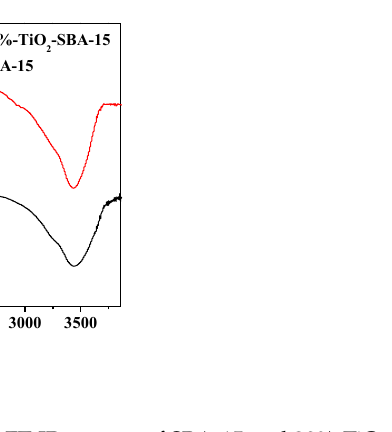
Figure 6. ( a ) FT-IR spectra of SBA-15 and 20%-TiO 2 -SBA-15, ( b ) FT-IR spectra of 20%-TiO 2 -SBA-15 (wavenumber from 600–1000 cm − 1 ) from circle marked in ( a ).